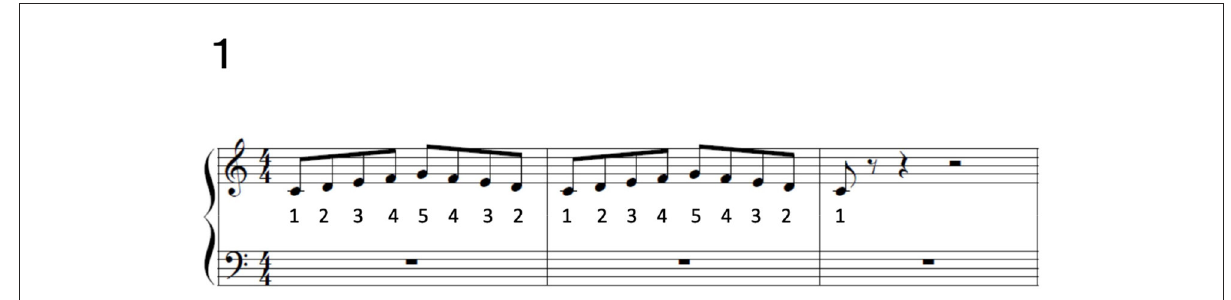
FIGURE1 Piece #1. The numbers below musical notes indicate the fingers to use to play each note: 1 indicates the thumb, 2 indicates the index finger, 3 indicates the middle finger, 4 indicates the ring finger, and 5 indicates the little finger.